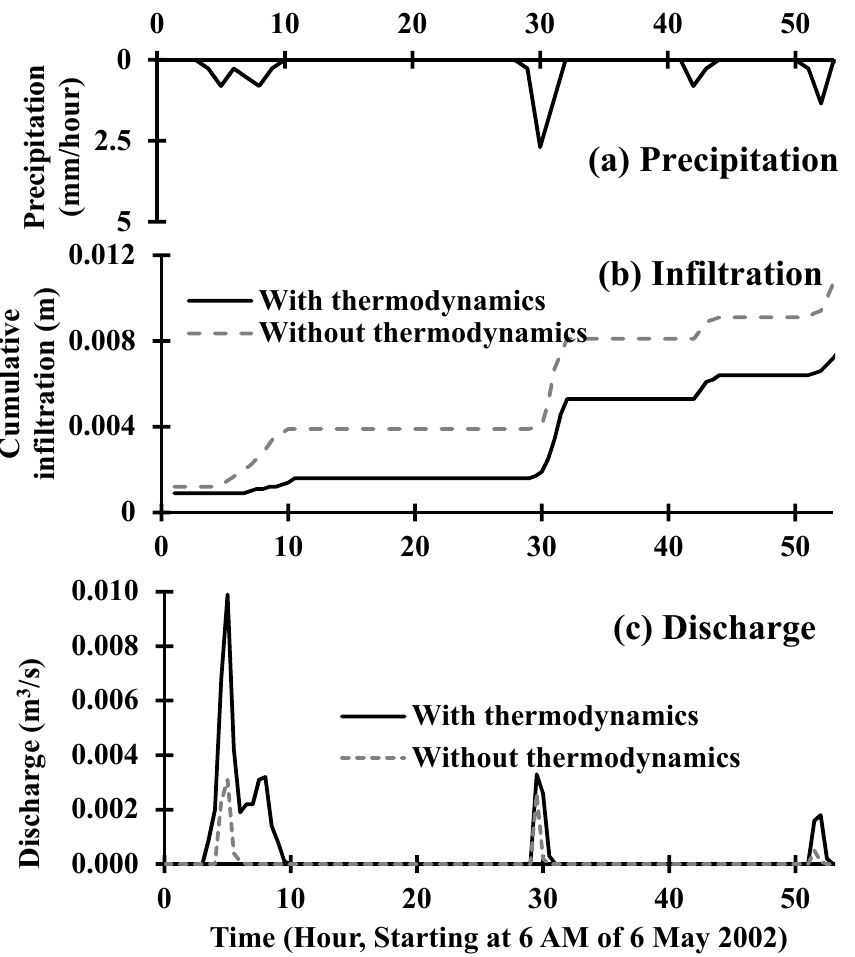
Figure 8. Hydrologic response, with and without thermodynamics, to precipitation events: ( a ) precipitation events ( b ) infiltration comparison ( c ) discharge comparison.